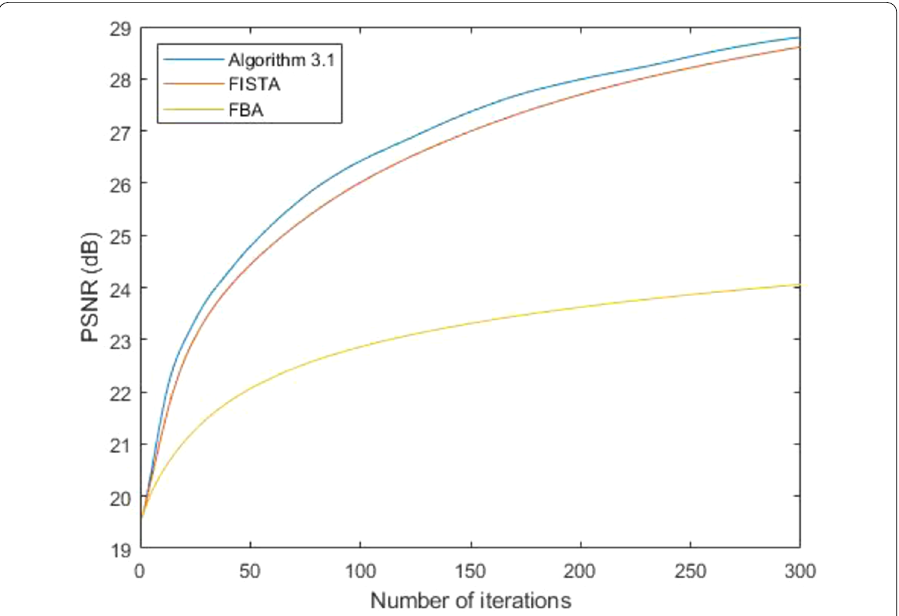
Figure 1 The graphs of PSNR of each algorithm for Wat Chedi Luang